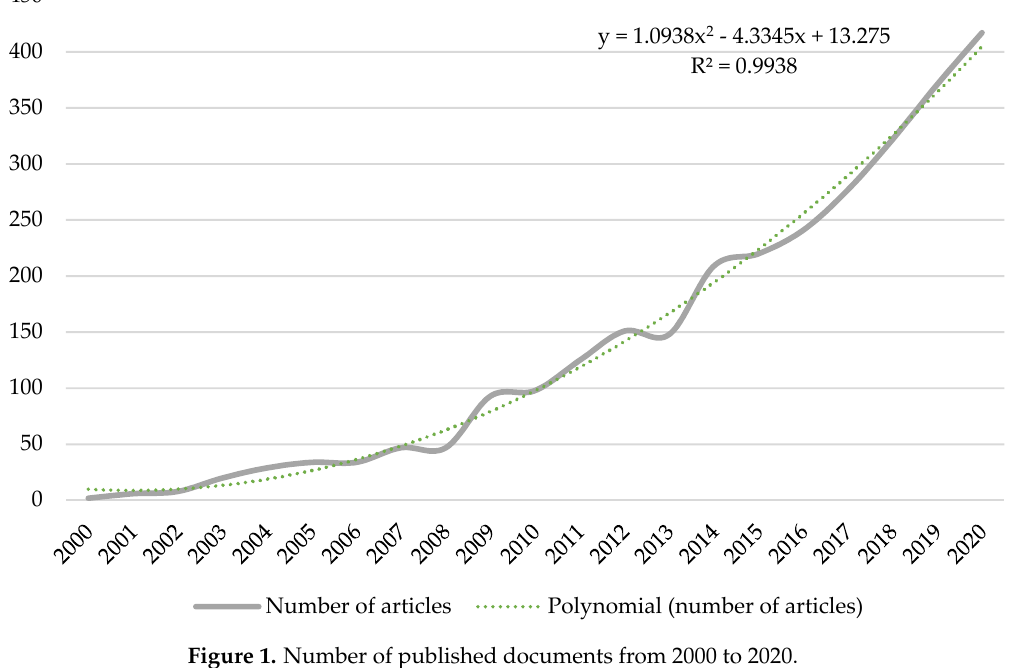
Figure 1. Number of published documents from 2000 to 2020.